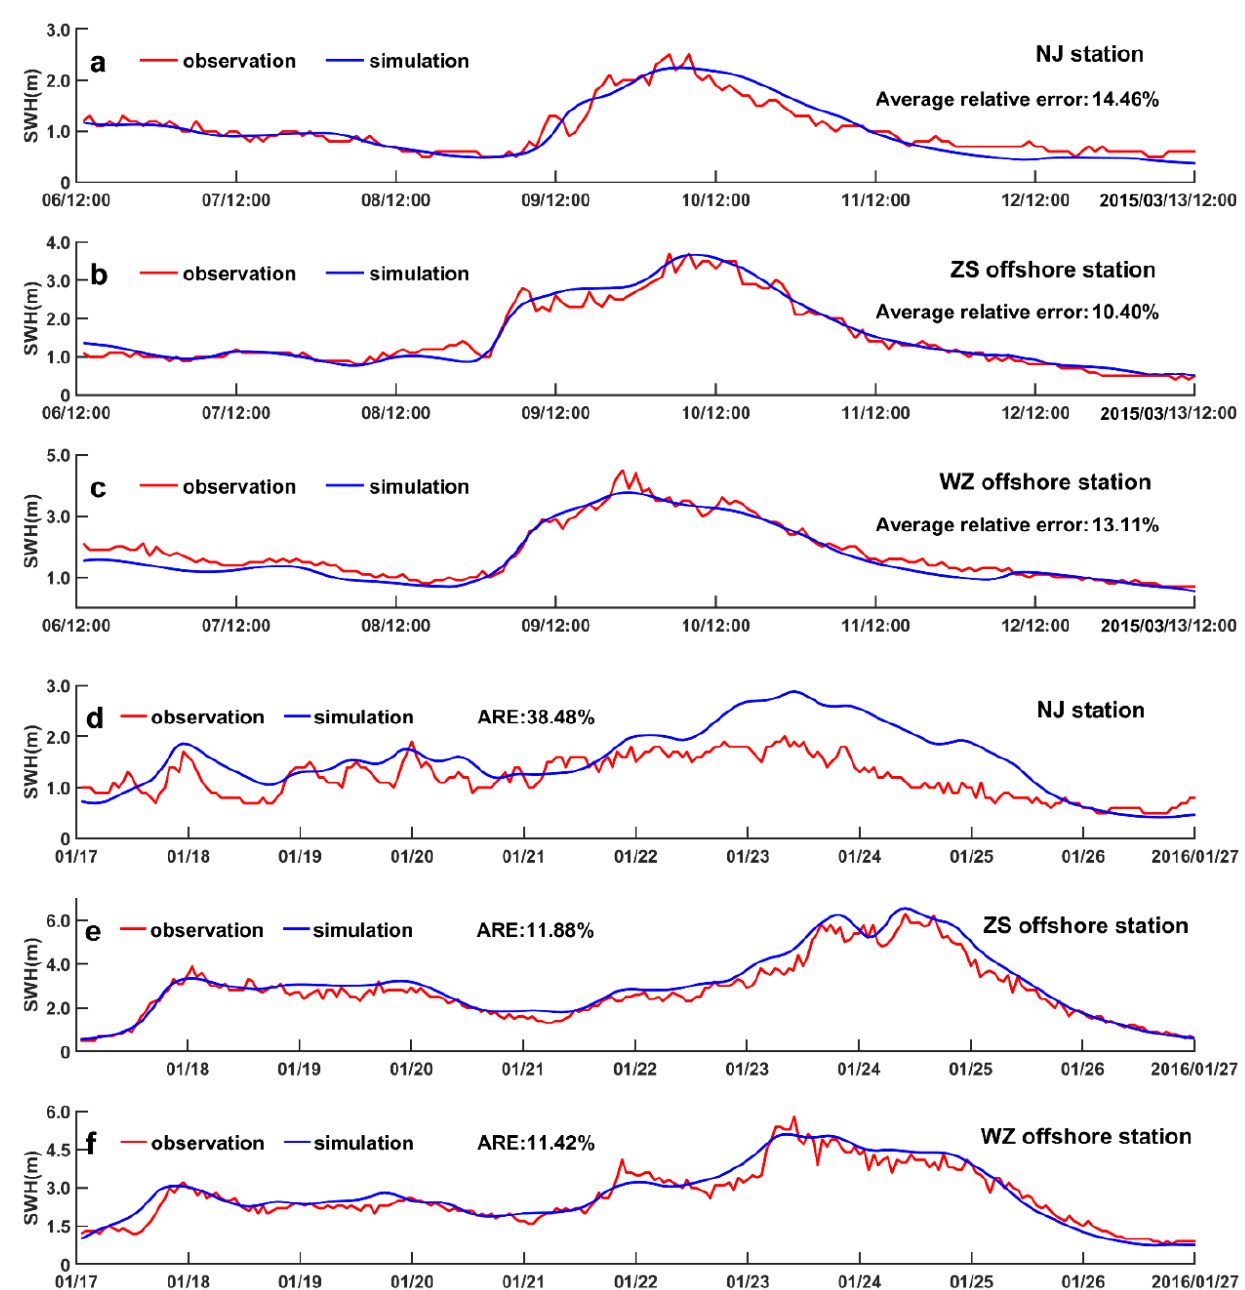
Figure 4. Comparison between the observed and simulated SWHs at ( a ) NJ station from 6 March 2015, to 13 March 2015, ( b ) ZS offshore station from 6 March 2015, to 13 March 2015, ( c ) WZ offshore station from 6 March 2015, to 13 March 2015, ( d ) NJ station from 17 January 2016, to 27 January 2016, ( e ) ZS offshore station from 17 January 2016, to 27 January 2016, and ( f ) WZ offshore station from 17 January 2016, to 27 January 2016.